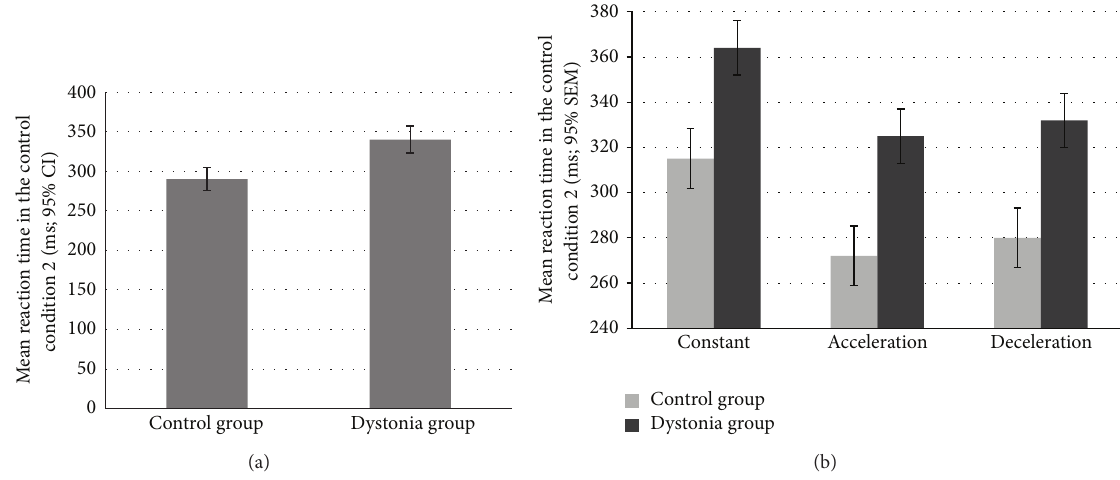
Figure 2: Reaction times. (a) Mean reaction time in the control condition 2: the reaction time of the patients was significantly slower than the reaction time in the control group. (b) Mean reaction times as a function of movement type in two groups: These results show that even if the patient group was generally slower (Figure 2), the reaction time was not affected by other parameters of the moving target (speed, acceleration) in a different way. This finding excludes the eventuality that the differences between the groups in the other main parameters may be due to oculomotor difficulties in the cervical dystonia group [37].